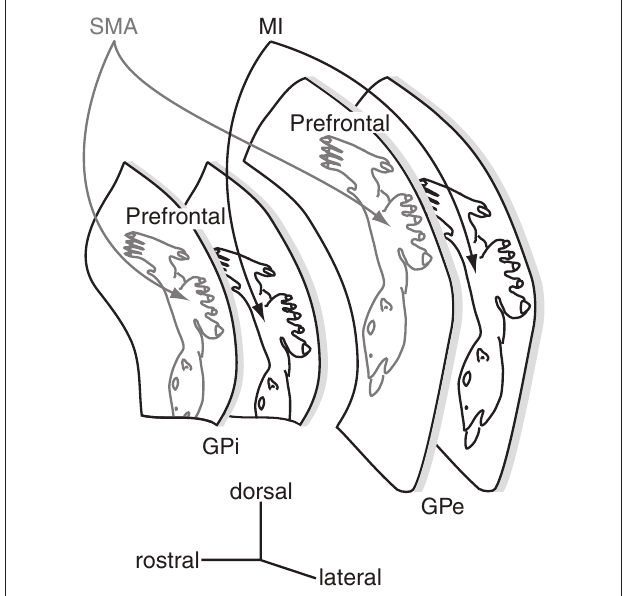
Figure 5 | Somatotopy of the external and internal segments of the globus pallidus (gPe and gPi). The GPe and GPi have their own somatotopic representations. The somatotopy in the SMA territory is located rostrodorsally to that in the MI territory. Two territories overlap partly in the rostro-caudal zone. Dorsal one-third of the GPe/GPi is occupied by the